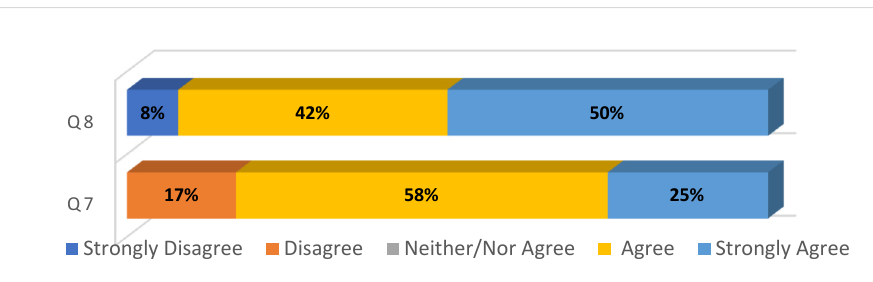
Figure 20. Distribution of answers to post-test questionnaire: belief layer.